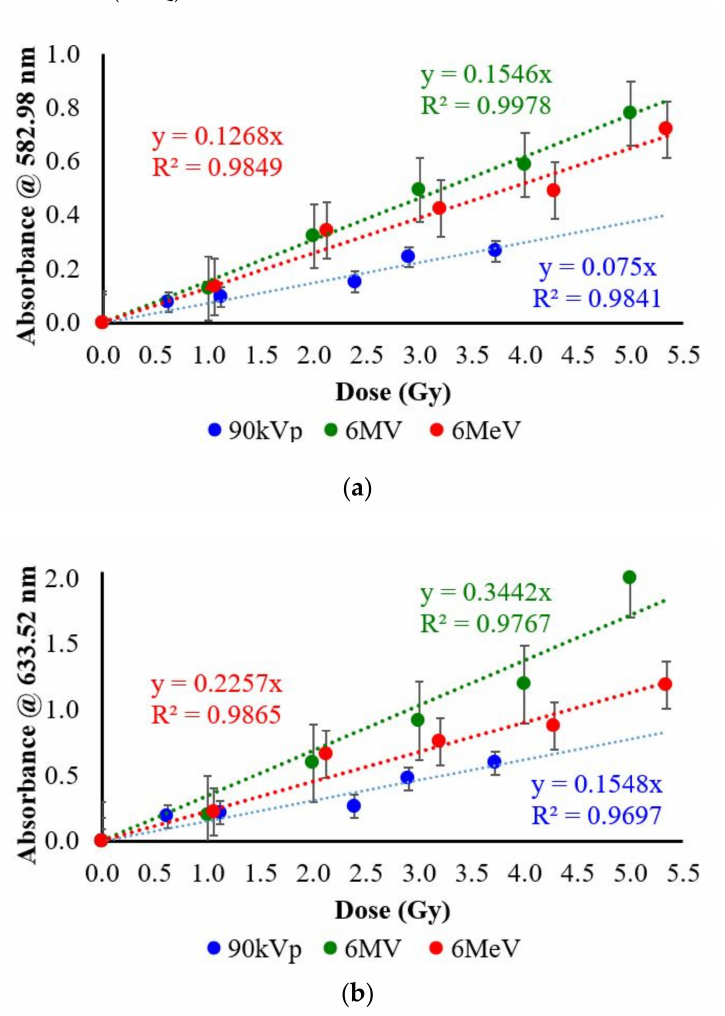
Figure 3. Linear graph of absorbance at peak ( a ) λ = 582.98 nm and λ = 633.52 nm ( b ). In contrast, in the results obtained in the basic peak range at λ = 633.52 nm, ex- pired EBT3 film showed higher responsivity for the 6-MV photon beam with a gradient m = 0.4206 and showed the best fitted regression line with the highest value for R 2 (95.5%) as compared with the others; 90 kVp X-rays showed the lowest responsivity with gradient m = 0.1302 and the lowest fitted regression line, which was 86.5%. Using equations to derive (LOD) and quantitative (LOQ), 90 kVp achieved 2.522 for (LOD) and 7.644 for (LOQ), 6 MV achieved 0.452 for (LOD) and 1.369 for (LOQ), and finally 6 MEV achieved 1.207 for (LOD) and 3.657 for